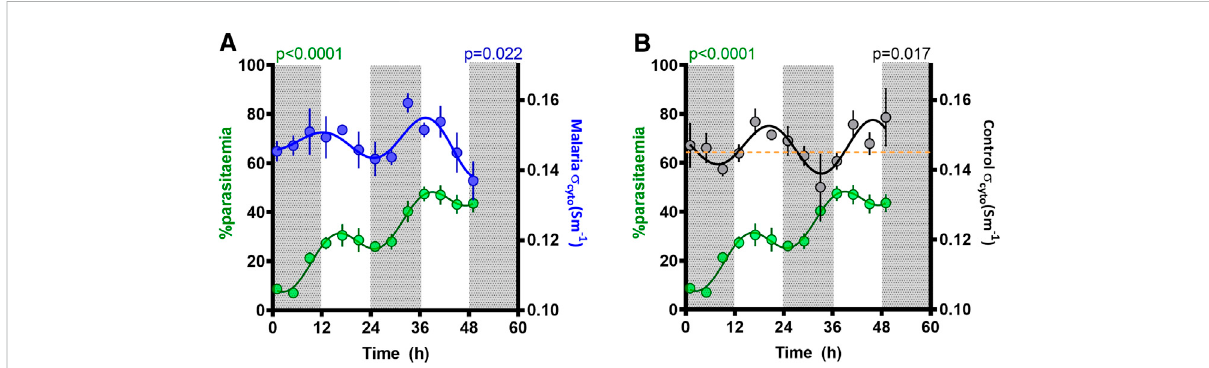
FIGURE 5 Parasitemia rhythm and correlation with cytoplasmic conductivity ( σ cyto ). Mean ± SEM and best fi tting models for σ cyto in (A) malaria (blue) and (B) control (black) groups, as well as parasitemia in malaria mice (green), as a function of time since the experiment began, with ZT indicated by light and dark panels. The yellow line in Figure 5B refers to the threshold of σ cyto = 0.145 Sm − 1 ; periods when σ cyto is below this threshold coincides with times that parasitemia